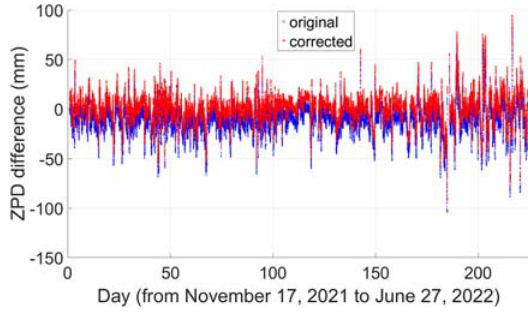
Figure 12. ZPD difference between BRUX and REDU.